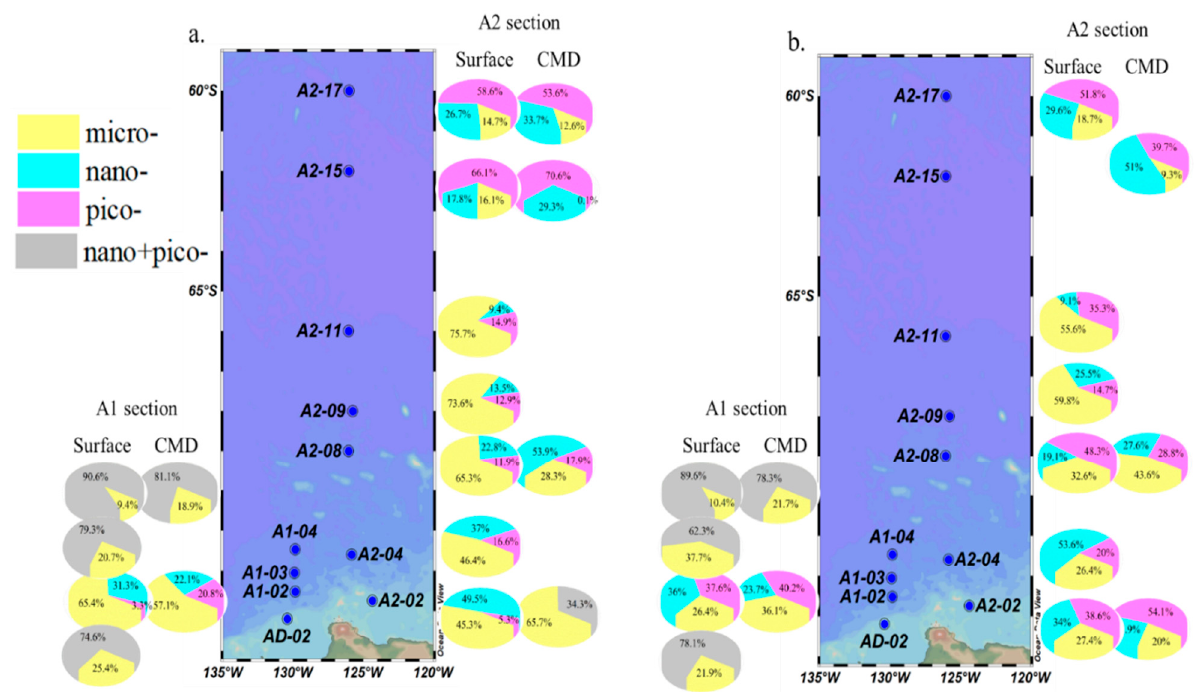
Figure 6. The contributions of the size-fractionated CFR ( a ) and FeUR ( b ) to the total CFR and FeUR. The left and right sides outside the sampling map represent sections A1 and A2, respectively. Different colors represent the contributions of phytoplankton of different sizes, where yellow represents micro-plankton, light blue represents nano-plankton, pink represents pico-plankton, and grey represents nano- and pico-plankton, respectively.